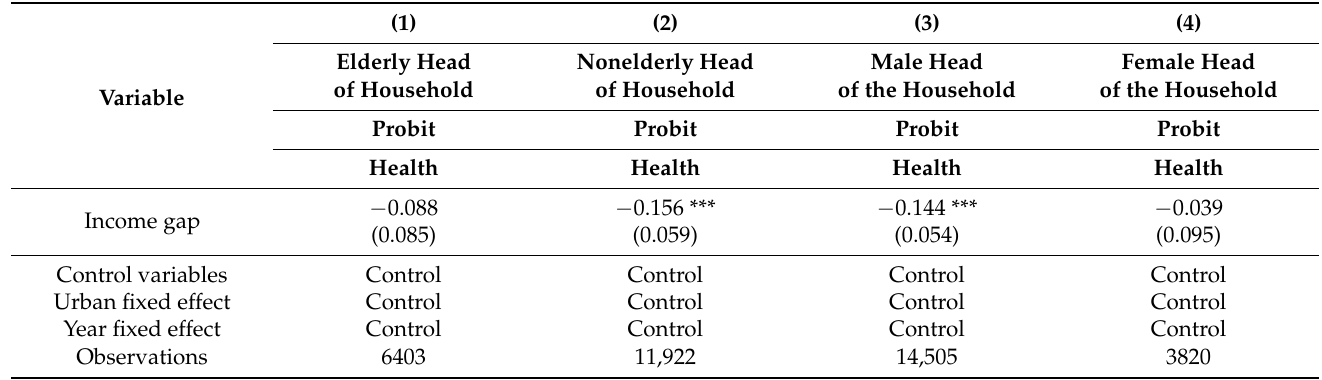
Table 11. Heterogeneity analysis results (age and gender